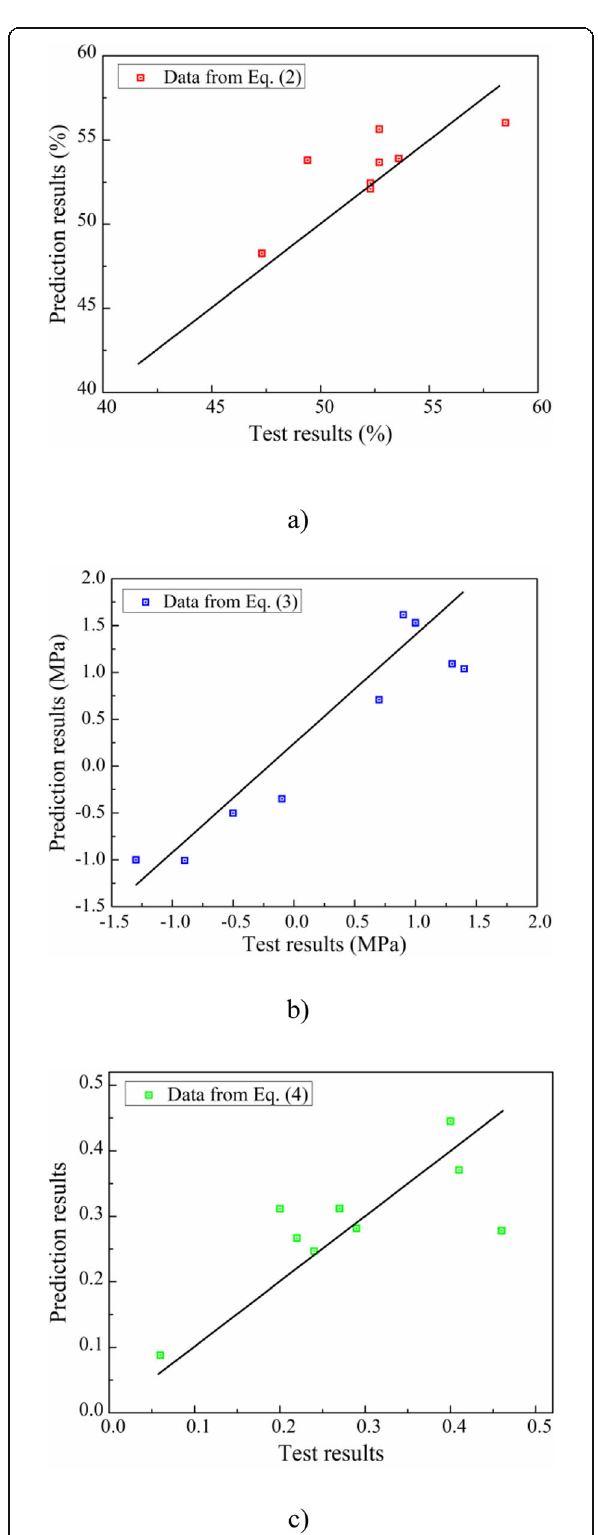
Fig. 7 Comparison between prediction results and test results: a) data from Eq. (2); b) data from Eq. (3); and c) data from Eq.